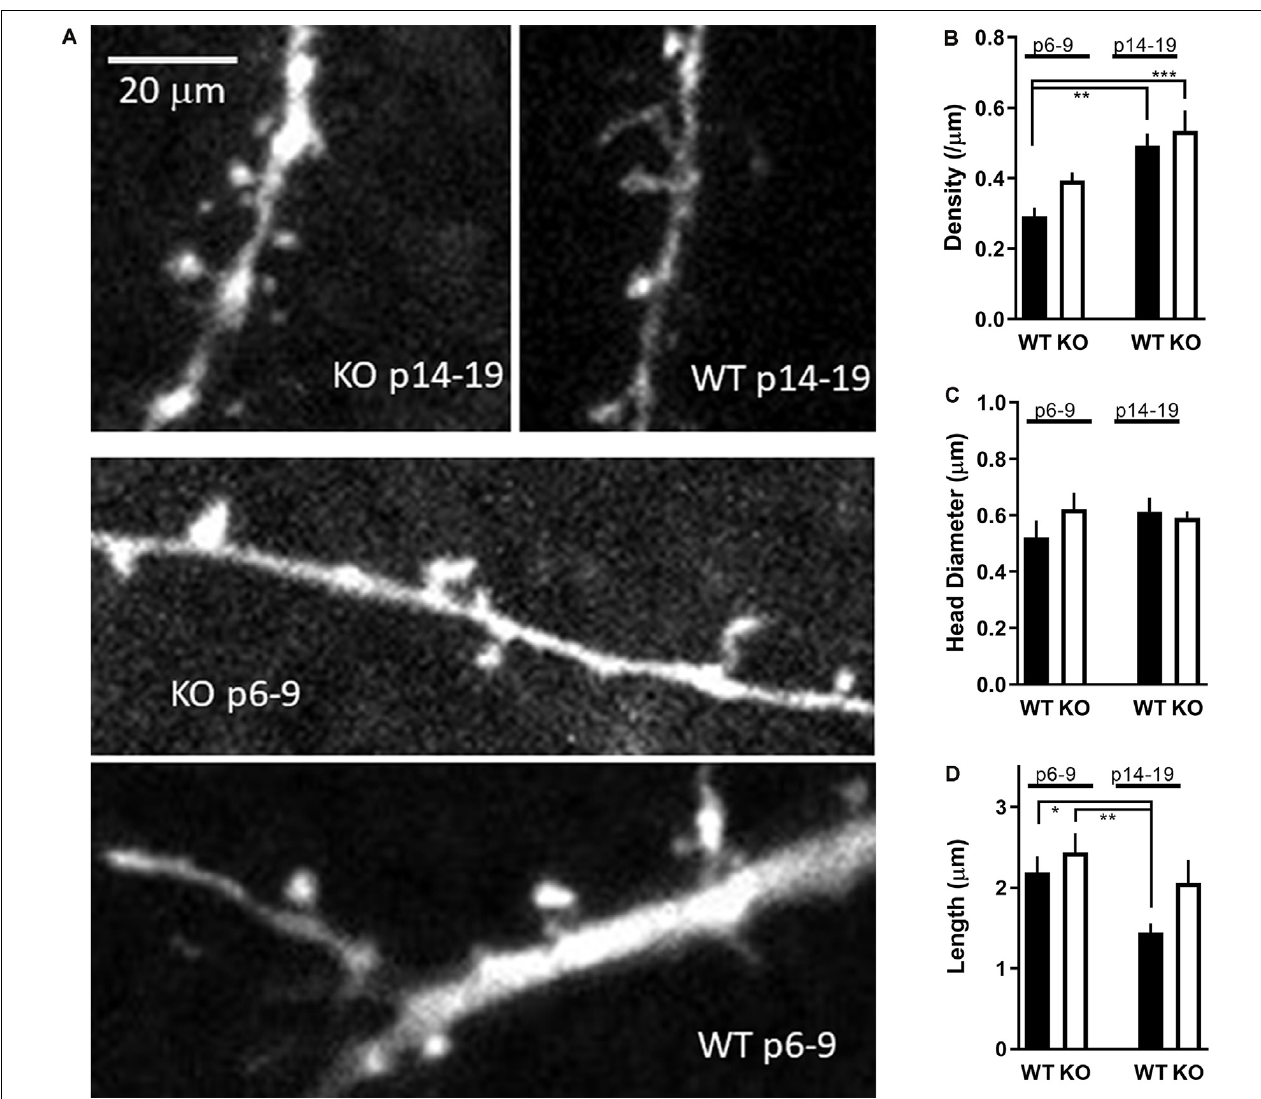
FIGURE 7 | Development of dendritic spines in FMR1 KO CA1 neurons. (A) Sample images of apical dendrites with spines from WT and FMRP KO neurons as indicated in the figure. A total of 17–21 KO and 23–27 WT neurons were analyzed for spine morphology in the P6–9 and P14–19 groups, respectively. The scale bar is shown in the upper left is 20 µ m. (B) Spine density in WT CA1 neurons (black bars) or FMRP KO neurons (white bars) from slices P6–9 or P14–19 as indicated. The asterisk indicates significance using one-way ANOVA ( F (1.959,15.67) = 8.663) with Tukey post hoc analysis. (C) Spine head diameter from CA1 neurons as in panel (B) . (D) Spine length from CA1 neurons as in panel (B) . Asterisk indicates statistical significance (one-way ANOVA F (F1.872,14.35) =